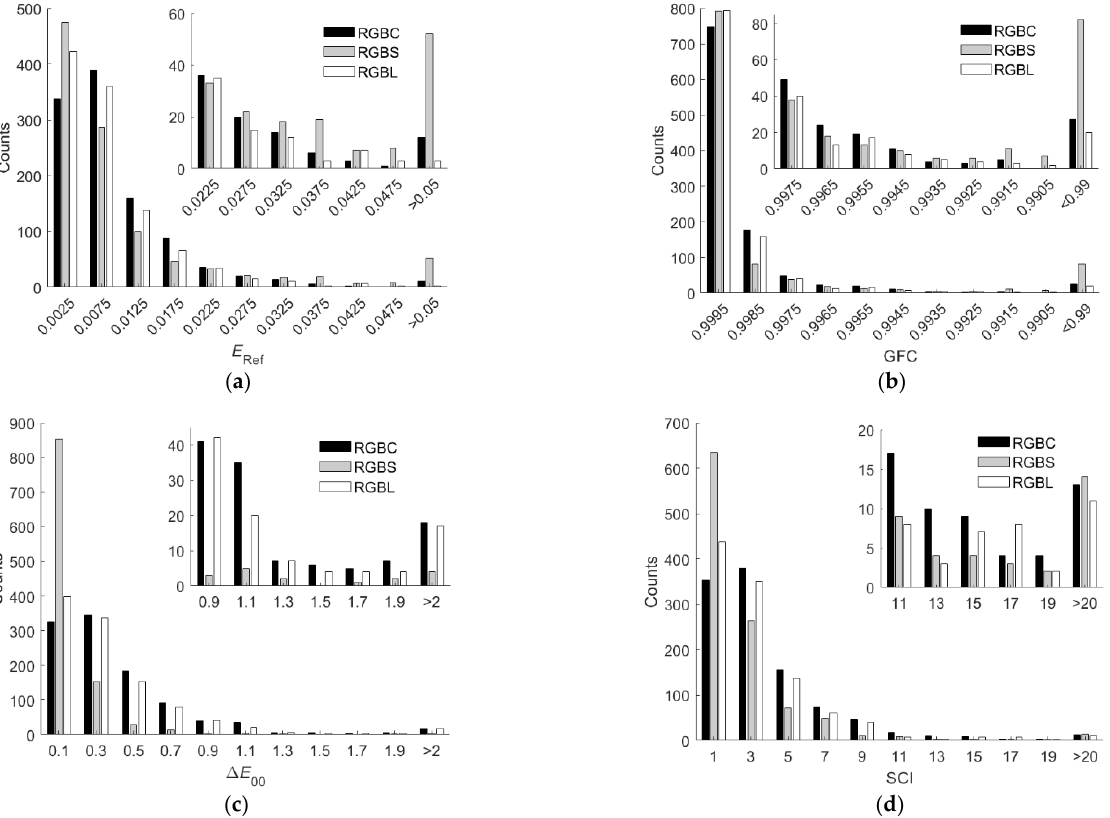
Figure 12. The same as Figure 11 except that spectra were reconstructed using the wPCA method. ( a ) E Ref , ( b ) GFC, ( c ) ∆ E 00 and ( d ) SCI histograms for the 1066 test